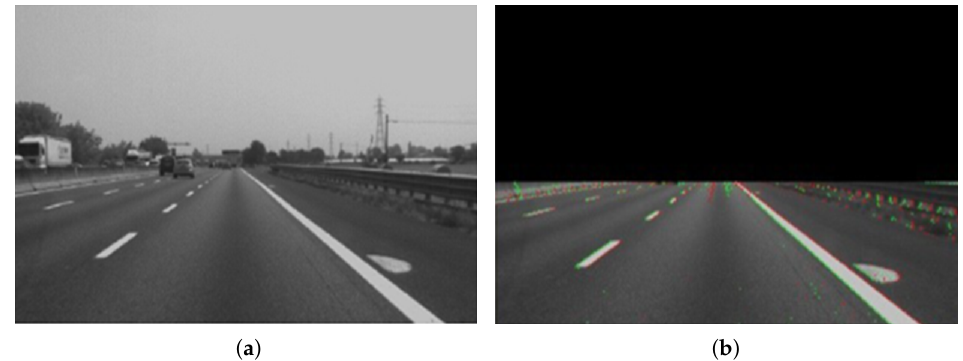
Figure 1. Edge detection result: ( a ) input image, and ( b ) edge detection result.